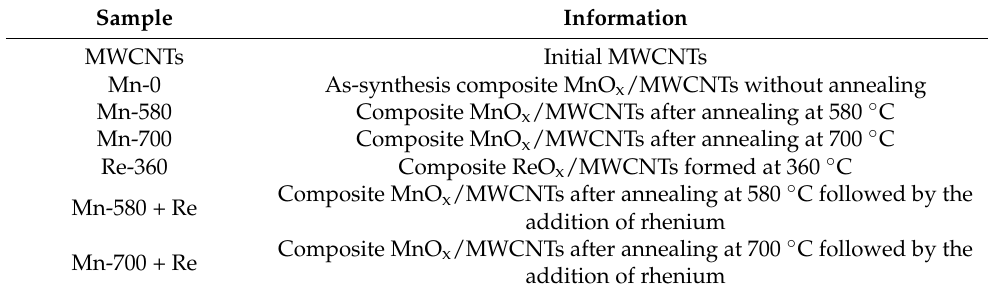
Table 1. Designation of